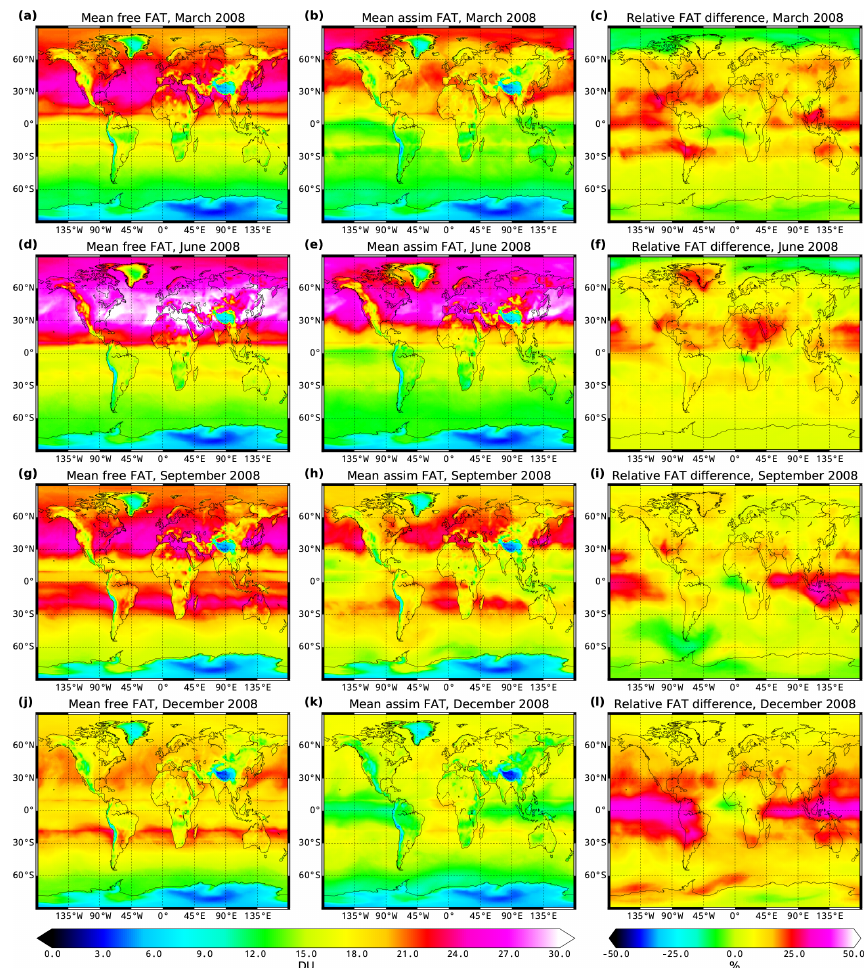
Figure 1. Monthly mean tropospheric O 3 fields. Panels (a, d, g, j) : free model run; (b, e, h, k) : assimilated O 3 fields; (c, f, i, l) : the relative difference ((free-assim)/free × 100). From top to bottom: March (a, b, c) , June (d, e, f) , September (g, h, i) and December (j, k, l)